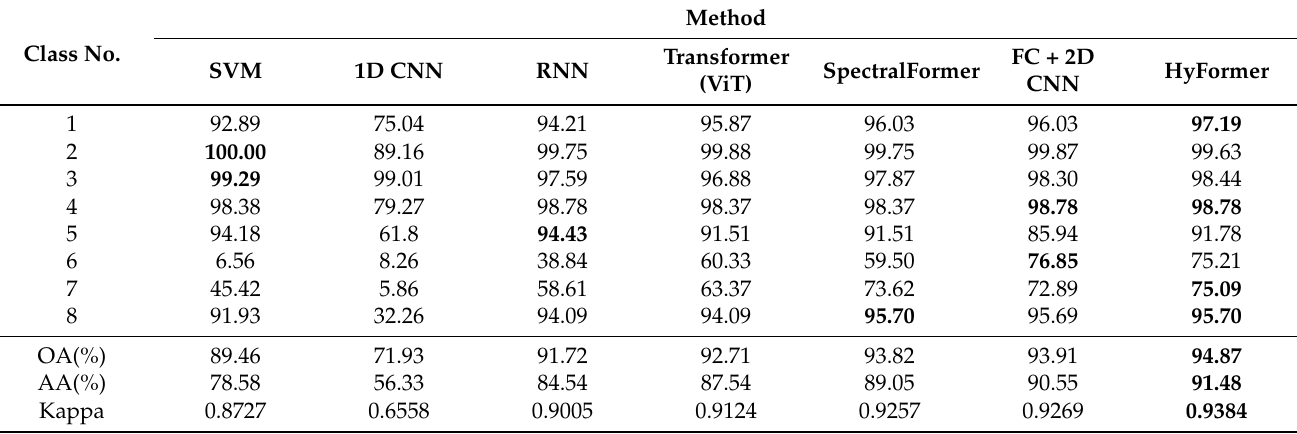
Table 11. Comparison of classification results of different classification methods applied on the testing set of Changxing County,